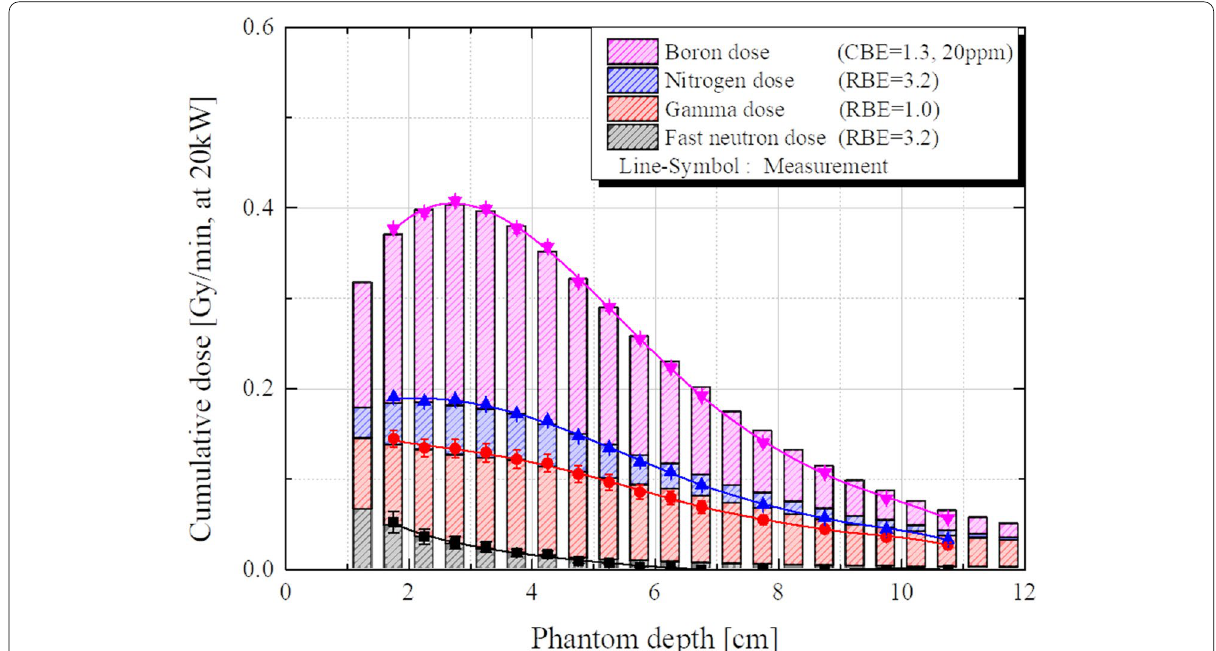
Fig. 20 Percentage contribution of individual dose components (D N , D B , D γ , and D fast ) to the weighted total brain dose, as a function of depth along the central axis inside the phantom. Proton linac operating at 20 kW. The first 10 mm in the phantom is the thickness of water behind the beam port plane; an air gap and then the phantom wall thickness. The phantom was irradiated with an epithermal neutron flux of 1 cm 2 ⋅ s which was confirmed by neutron activation. The brain is assumed to have a 10 B concentration of 20 ppm in normal tissues, a nitrogen mass percentage of 2.22 for the thermal neutron dose, and a hydrogen mass percentage of 10.7 for the fast neutron dose. The weighting factors are RBE 3.2 for D N and D fast , RBE 1 for D γ , and CBE 1.3 for D B = = =